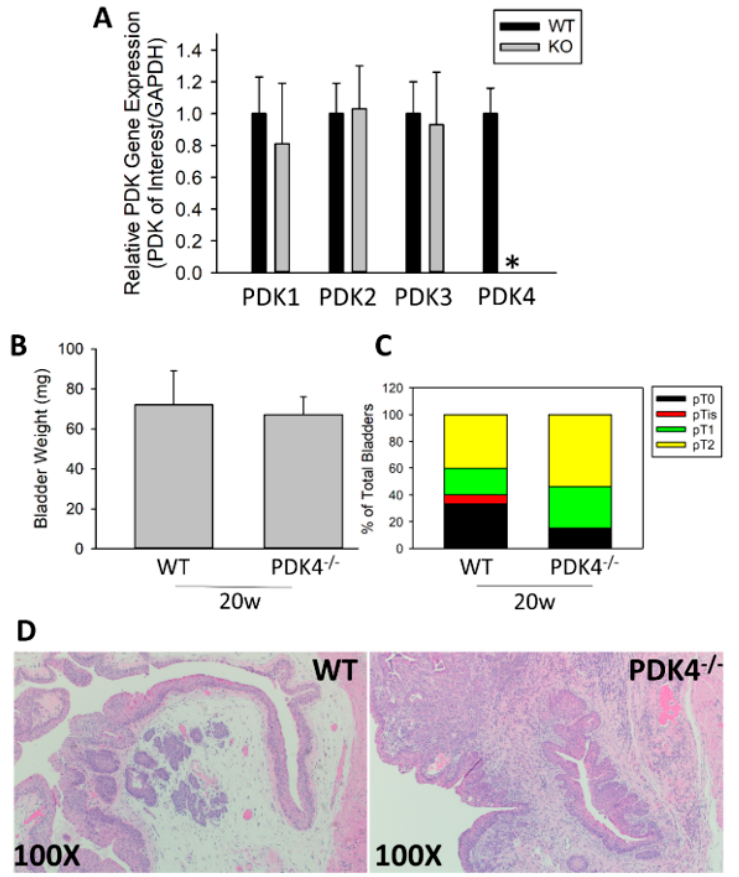
Figure 1. Early tumors are similar between WT and PDK4 − / − mice after BBN treatment. PDK4 gene expression was determined at baseline in bladders of untreated animals ( A ) WT ( n = 15) or PDK4 − / − ( n = 13) animals were placed on BBN for 16 w, followed by sacrifice at 4 w post BBN (20 w total). Bladder weights ( B ) and tumor stage ( C , D ) were measured. * p <